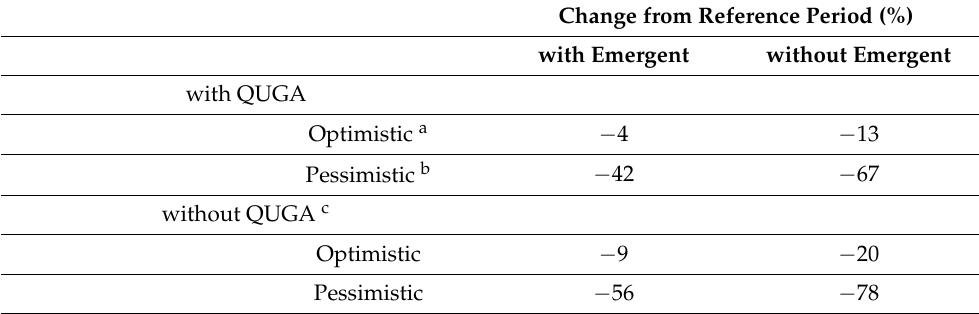
Table 6. Changes in forest and woodland niche area projected in the future based on integration of species changes. Change from Reference Period (%) with Emergent without Emergent with QUGA Optimistic a − 4 − 13 Pessimistic b − 42 − 67 without QUGA c Optimistic − 9 − 20 Pessimistic − 56 −